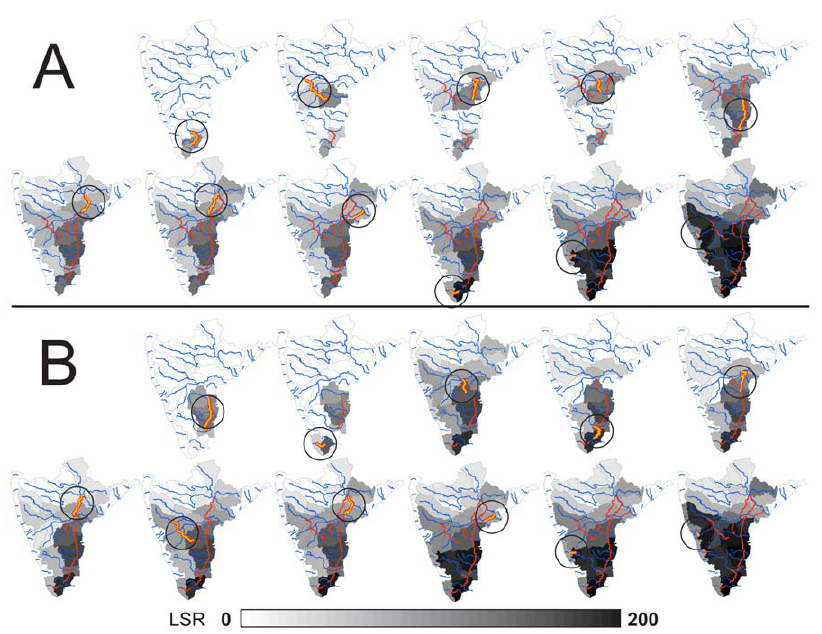
Figure 4. Change in local species richness (LSR) for each of the 31 river sub-basins as each canal is implemented. We show results from both the the economic (A) and ecological (B) linking strategies. Sub-basins are outlined in gray, major rivers in blue, and canals are indicated in red; the link added in each step is in yellow. Darker shades indicate greater increase in LSR (relative to the LSR after 130 generations with no canal links implemented). All other symbols follow Fig. 1.